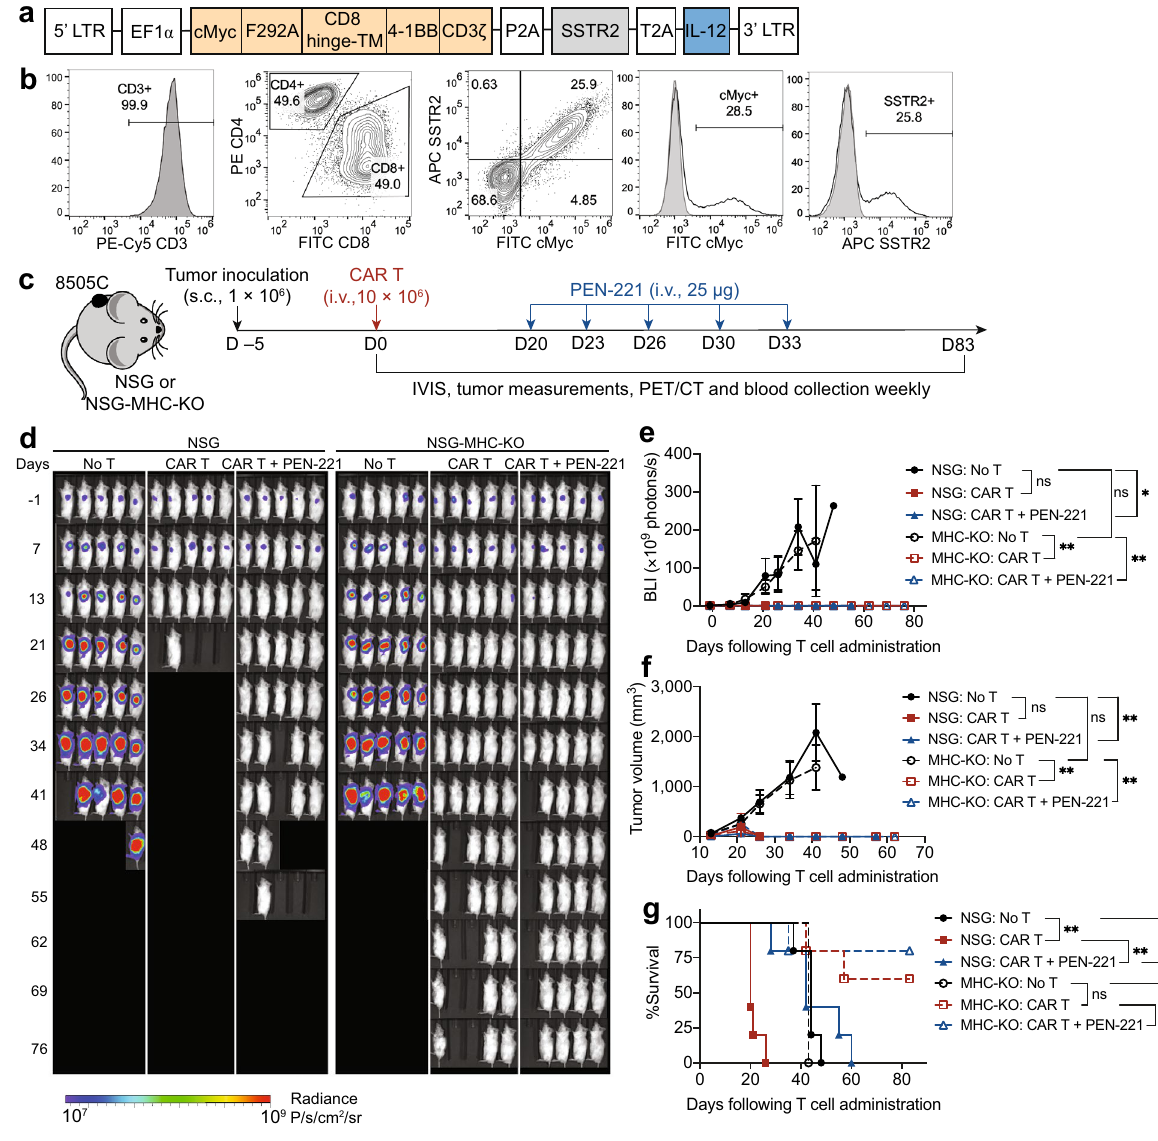
Figure 3. PEN-221 treatment mitigates CAR T-associated toxicity in vivo and elongates survival. ( a ) Schematic of the tricistronic lentiviral vector encoding the 2nd generation ICAM1-specific CAR (F292A-4-1BB-CD3ζ), human SSTR2 and human IL-12. Transgenes are separated by P2A and T2A ribosomal skipping sequences. F292A, a micromolar affinity I domain derived from LFA-1; CD8 hinge-TM, CD8 hinge and transmembrane domains; 4-1BB, 4-1BB costimulatory domain; CD3ζ, CD3ζ signaling domain. ( b ) Flow cytometry data showing CD3, CD4/CD8 subsets as well as CAR and SSTR2 expression detected by anti-cMyc and anti-SSTR2 antibodies. ( c ) Schematic of the ATC mouse model. Fluc-expressing 8505C cells (1 × 10 6 /mouse) were implanted subcutaneously into the upper left flank of NSG and NSG-MHC-KO mice and treated 5 days later with 10 × 10 6 primary CAR T cells or left untreated (No T). When mice started to show symptoms of toxicity, 25 μg PEN- 221 was intravenously administered every 3–4 days from day 20 to day 33. ( d ) Tumor growth was assessed by bioluminescence imaging on a weekly basis. ( e ) Tumor burden was estimated by the level of total body bioluminescence intensity. ( f ) Tumor volume was measured and plotted. Data represent mean ± SD of 5 mice per cohort. A two-way ANOVA with Tukey’s multiple comparisons test was used for statistical analysis. *, P < 0.05; **, P < 0.01; ns, not significant. ( g ) Kaplan–Meier survival curves. Statistical significance was determined by Log- rank (Mantel-Cox) test. *, P < 0.05; **, P < 0.01; ns, not